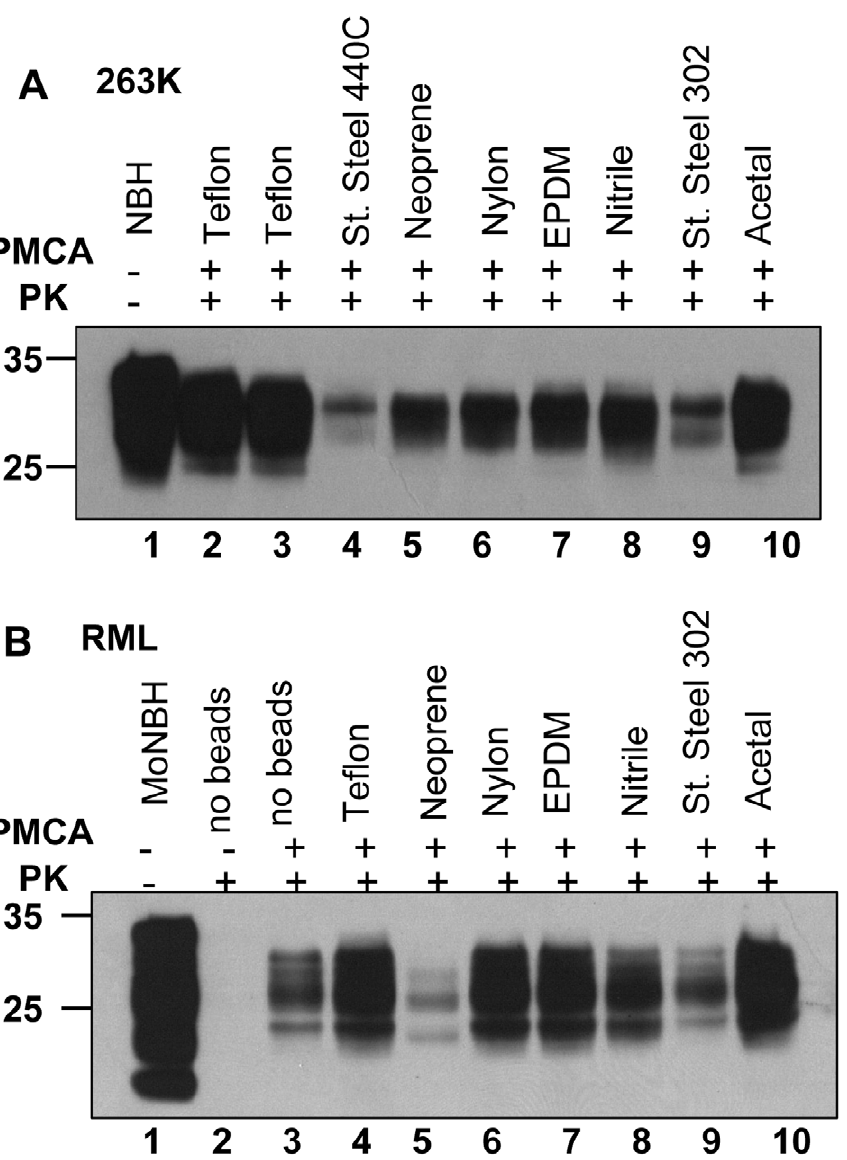
Figure 8. Effect of bead material on efficiency of amplification. ( A ) 263K scrapie brain material was serially diluted 10 5 -fold into 10% hamster NBH and subjected to 48 PMCA cycles in the presence of two beads made from Teflon (purchase from McMaster-Carr – lane 2, or Small Parts – lane 3), stainless steel 440C, neoprene, nylon, EPDM, nitrile, stainless still 302, or acetal, as indicated. Prior to electrophoresis, samples in lanes 2–10 were digested with PK. Undigested 10% hamster NBH (lane 1) was loaded as a reference. Without PMCA, 10 5 - fold diluted 263K brain material was not detectable by Western blotting (not shown). ( B ) RML scrapie brain material was serially diluted 10 4 -fold into 10% mouse NBH and subjected to 48 PMCA cycles in the absence of beads (lane 3) or presence of two beads made from Teflon (purchase from Small Parts – lane 4), neoprene, nylon, EPDM, nitrile, stainless still 302, or acetal, as indicated. Prior to electrophoresis, samples in lanes 2–10 were digested with PK. Undigested 10% mouse NBH (lane 1) was loaded as a